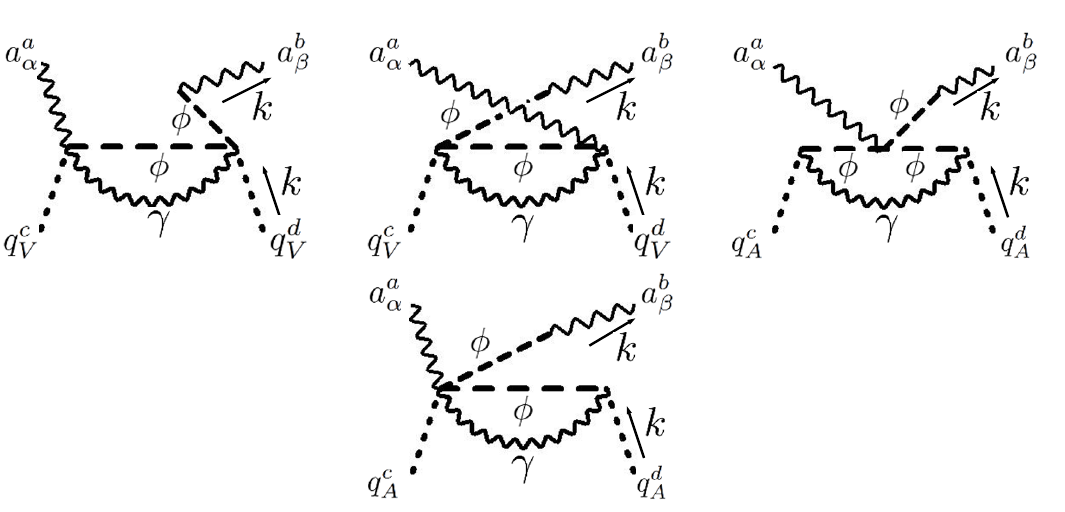
Figure 6 . Contributions from photon loops with a meson